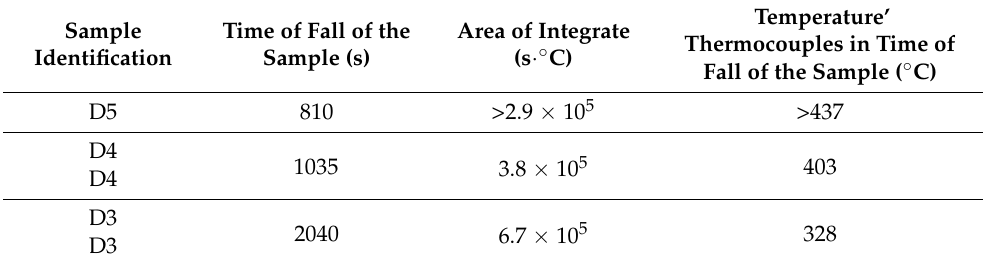
Figure 14. Reduction in MOR of the fiber cement boards depending on the localization above the upper splay. Table 2. Characteristic data of falling